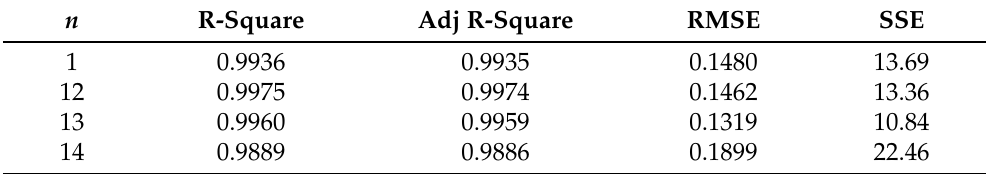
Table 3. Goodness of fit of the EC models.